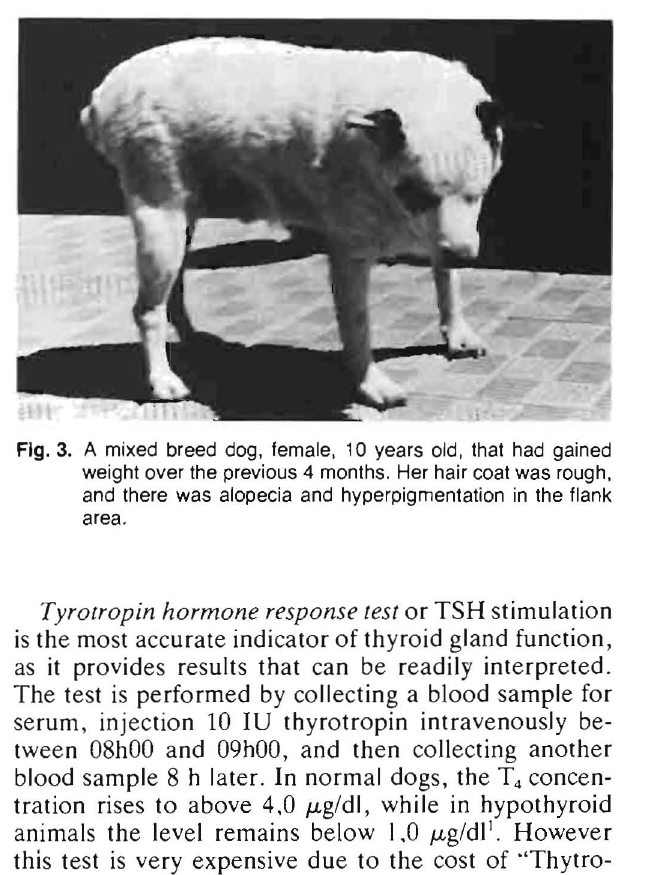
Table 2: SERUM THYROXINE RANGES FOR NORMAL AND HYPOTHYROID DOGS T. CPS